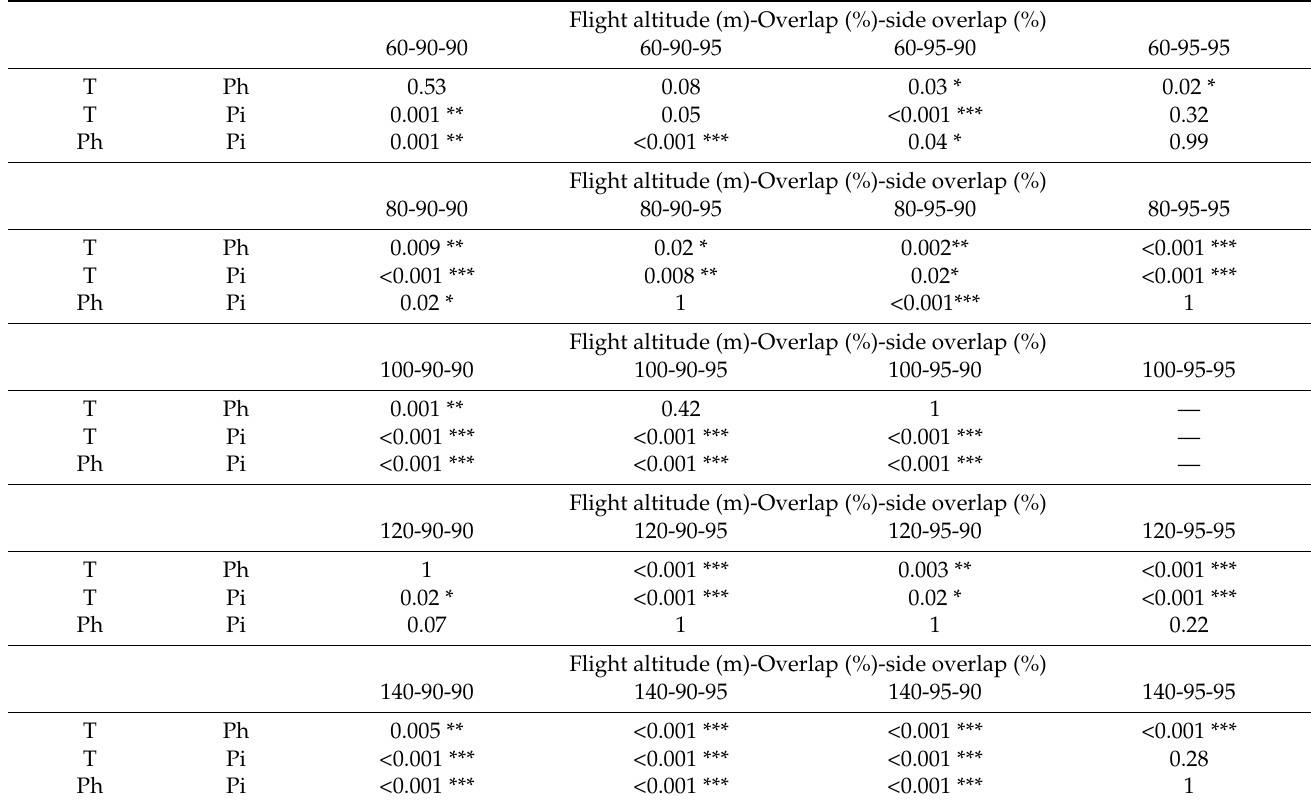
Table 4. Statistical results of multiple comparisons of the estimated crown